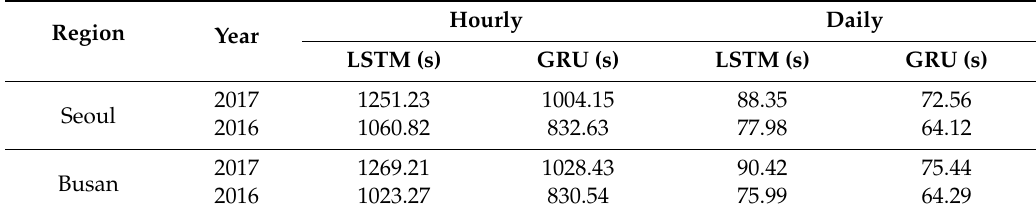
Table 10. The training time of LSTM vs. GRU.